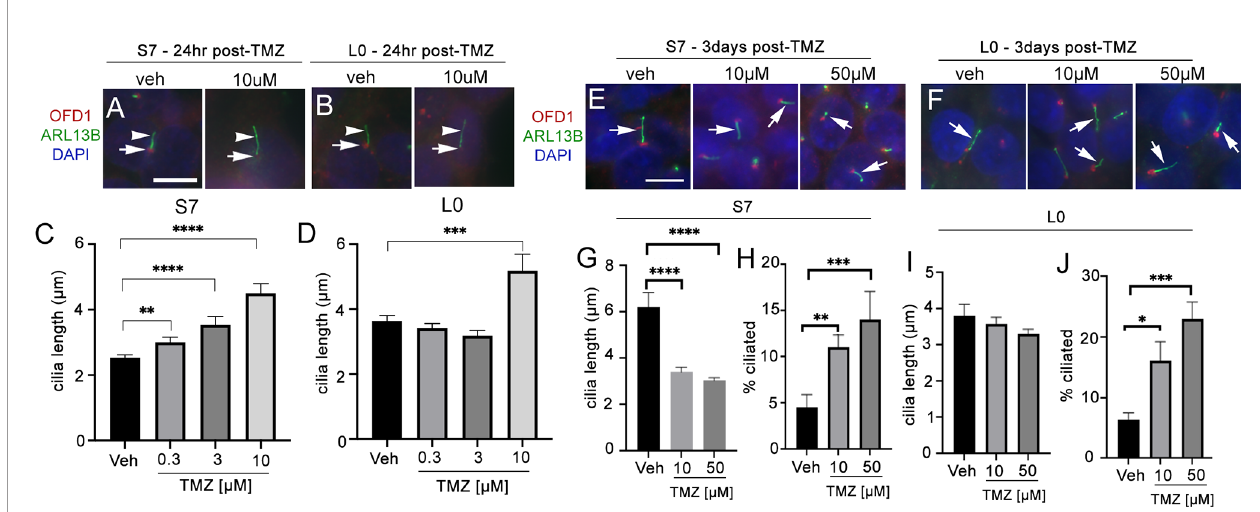
FIGURE 5 | Temozolomide stimulates ciliogenesis in L0 and S7 cells. (A) S7 and (B) L0 cells were grown for 24 h in vehicle or 10 µM TMZ. Cells were fi xed and immunostained for OFD1 (red) and ARL13B (green). Nuclei were labeled with DAPI. TMZ-treated cells appeared to show elongated ARL13B + cilia (arrowheads) and OFD1 intensity at the base of the cilia (arrows) appeared to decrease compared with vehicle in both cell lines. Scale bar = 10 µm. Mean lengths of cilia in (C) S7 and (D) L0 cells after a 24-h exposure to the indicated concentration (µM) of TMZ. (E) S7 and (F) L0 cells were grown for 72 h after one treatment of vehicle, 10 or 50 µM TMZ. Cells were fi xed and immunostained for OFD1 (red) and ARL13B (green). Arrows point to ARL13B + cilia in each treatment. Mean lengths of ARL13B + cilia in (G) S7 or (I) L0 cells 3 days after exposure to the indicated concentration (µM) of TMZ. Percent of ARL13B + cilia in (H) S7 or (J) L0 cells 3 days after exposure to the indicated concentration (µM) of TMZ. * p < 0.05, ** p < 0.01, *** p < 0.005, **** p < 0.0001